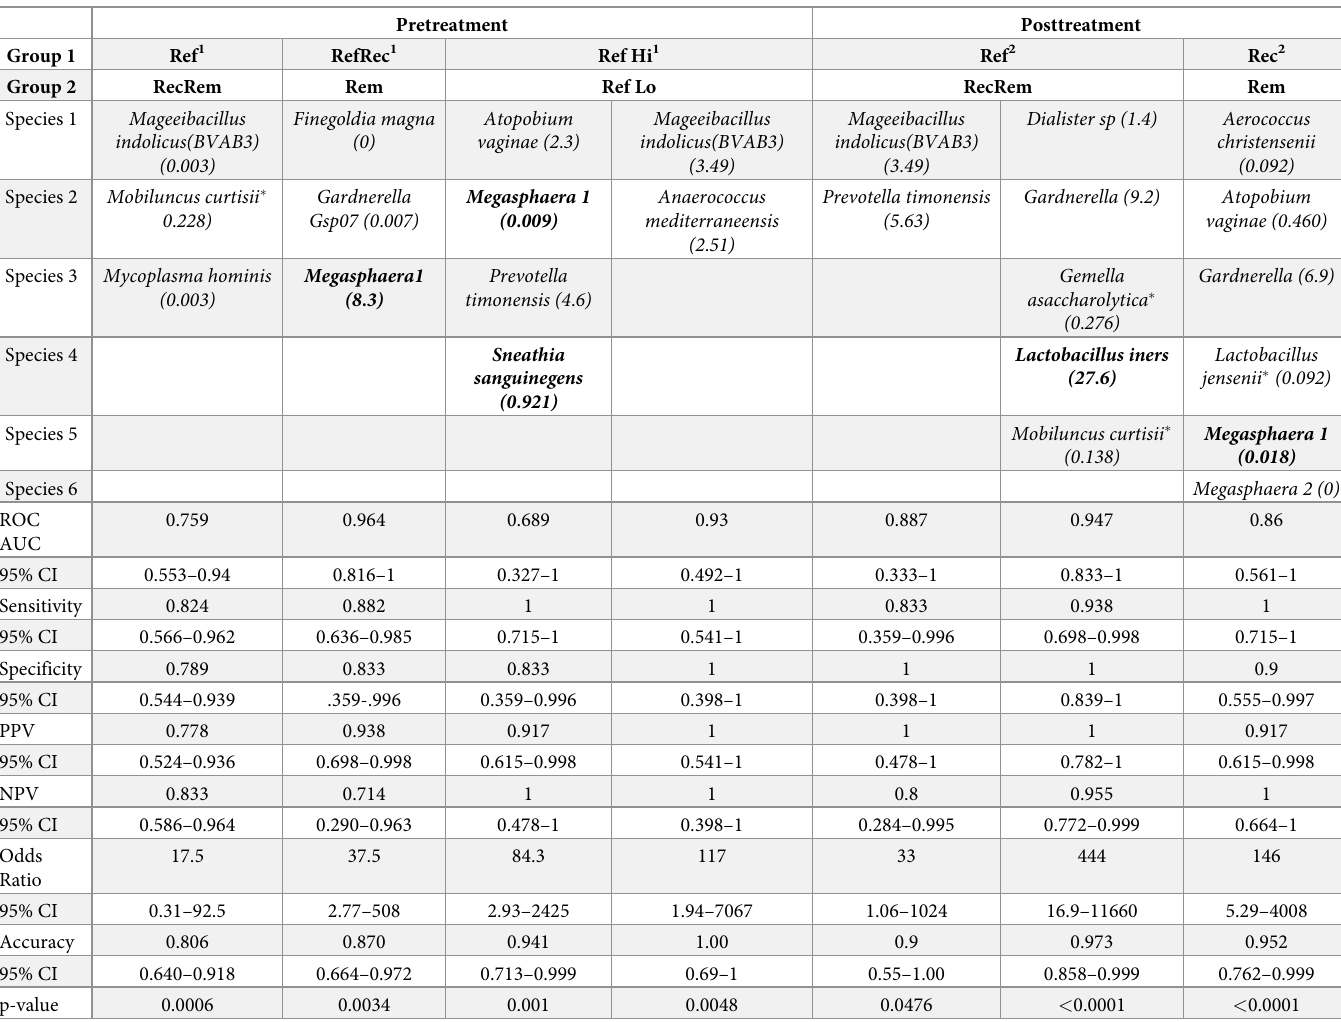
Table 1. Species combinations with significant prognostic